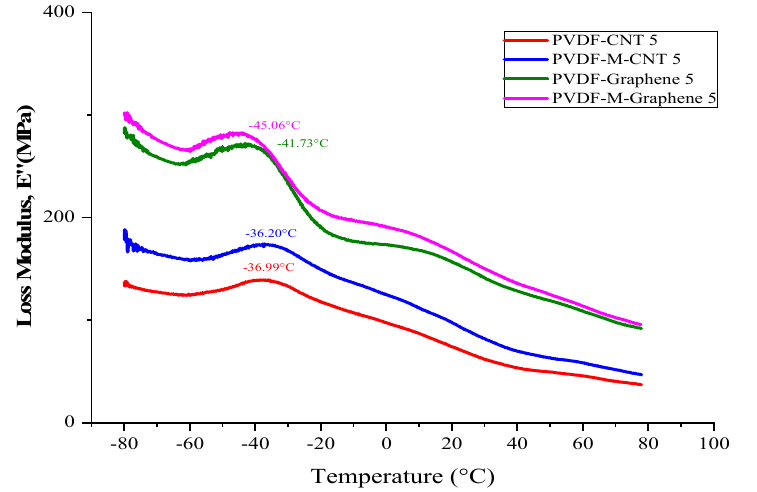
Figure 9. Loss modulus of the acid-treated and untreated MWCNT/GNF − PVDF nanocomposites.